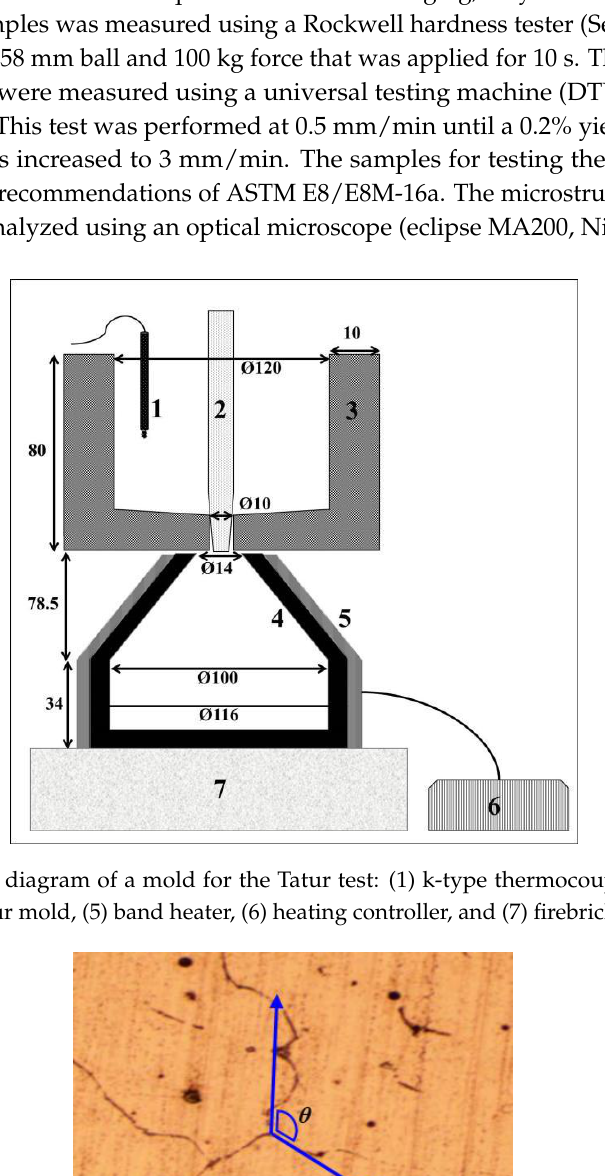
Figure 4. measurement of the dihedral angle of grain boundaries. Figure 4. Measurement of the dihedral angle of grain